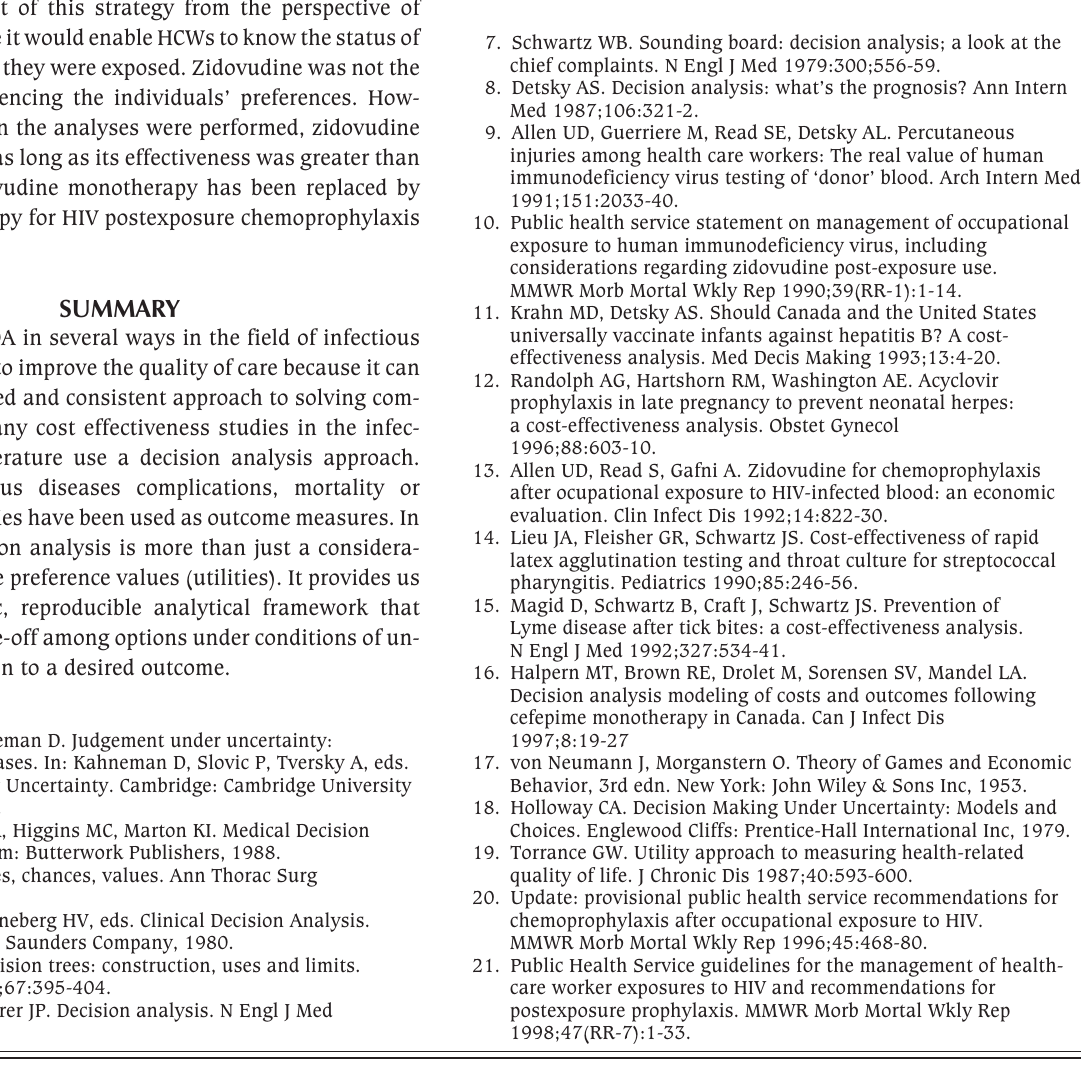
Figure 3) Varying the prevalence of HIV infection in the patient popu- lation and removing the ‘worrying factor’ due to HIV-seropositive ex- posure (one-way sensitivity analysis). It was assumed that no units of utility were subtracted as a result of a known HIV-seropositive expo- sure. The test strategy was the preferred strategy. The dramatic fall in the expected utility of the test option that was seen in Figure 2 is no longer